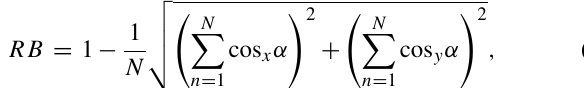
field also shows the reliability of the used 2D SECS